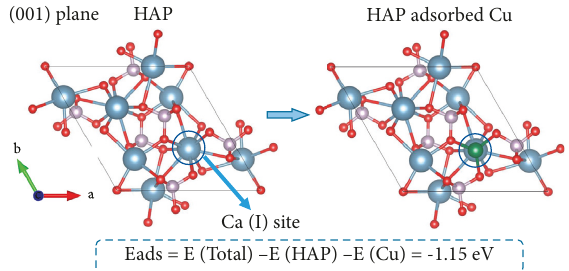
Figure 7: DFT calculation of copper adsorption energy on hy- droxyapatite. Copper adsorption on the pristine hydroxyapatite (001). Oxygen, calcium, phosphorus, hydrogen, and copper are in red, blue, pink, yellow, and green,